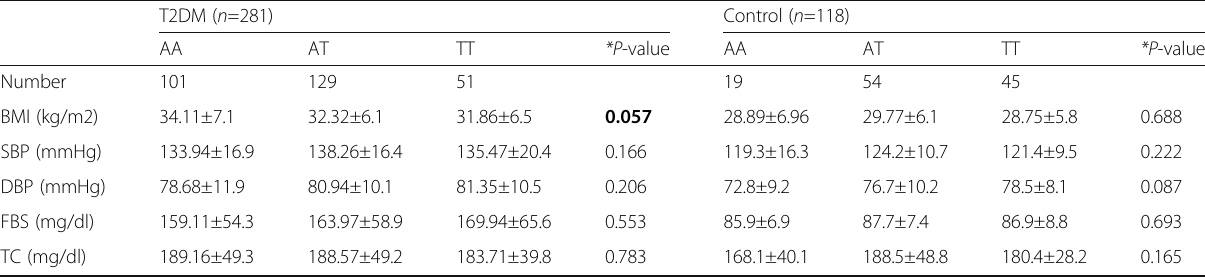
Table 4 Mean trait values stratified by glycemic status across FTO genotypes T2DM ( n =281)